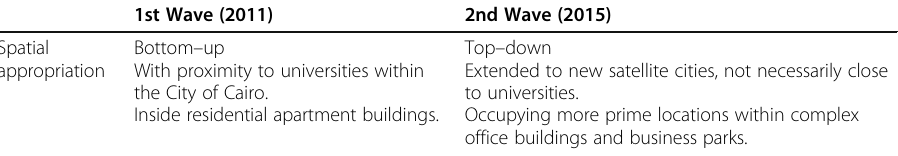
Top – down Extended to new satellite cities, not necessarily close to universities. Occupying more prime locations within